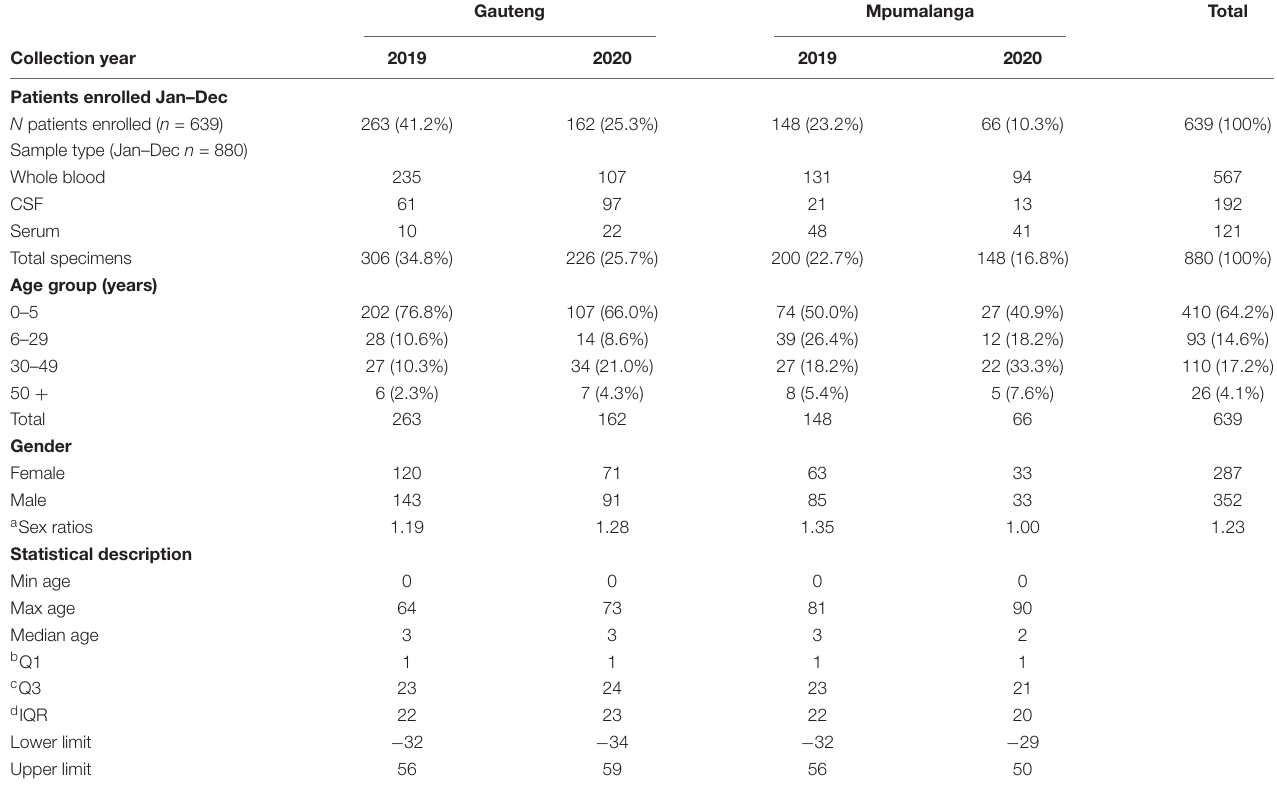
TABLE 1 | Demographic characteristics and summary statistics of the study population ( N =